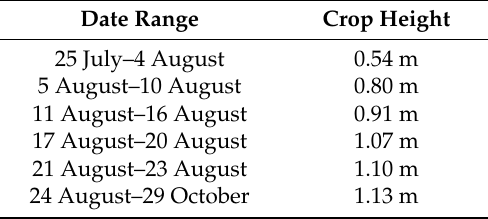
Table 1. Crop height measurements for the 2015 summer growing